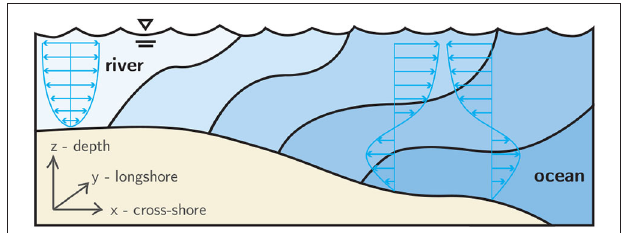
FIGURE 1 | Conceptual schematic of estuarine hydrodynamics. Shades of blue indicate water masses of differing salinity in a weakly-stratified estuary, and the blue arrows indicate tidally-modulated, oscillating flow